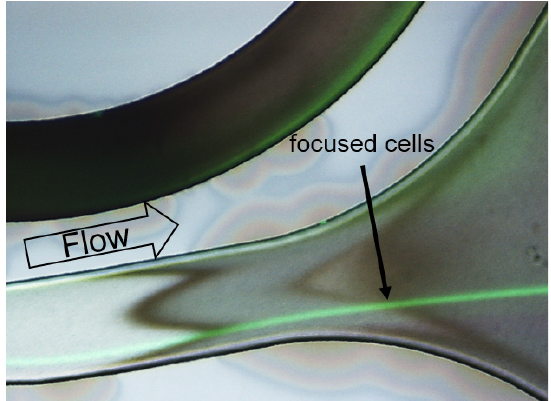
Figure 4. Overlay of a fluorescence reflected-light microscopy image of calcein AM stained CHO-K1 cells (green) crossing the spiral separator at a flow rate of 2.5 mL/min. Detailed view on a cut-out of the fabricated spiral separator close to the outlets. The cells are focused on a single